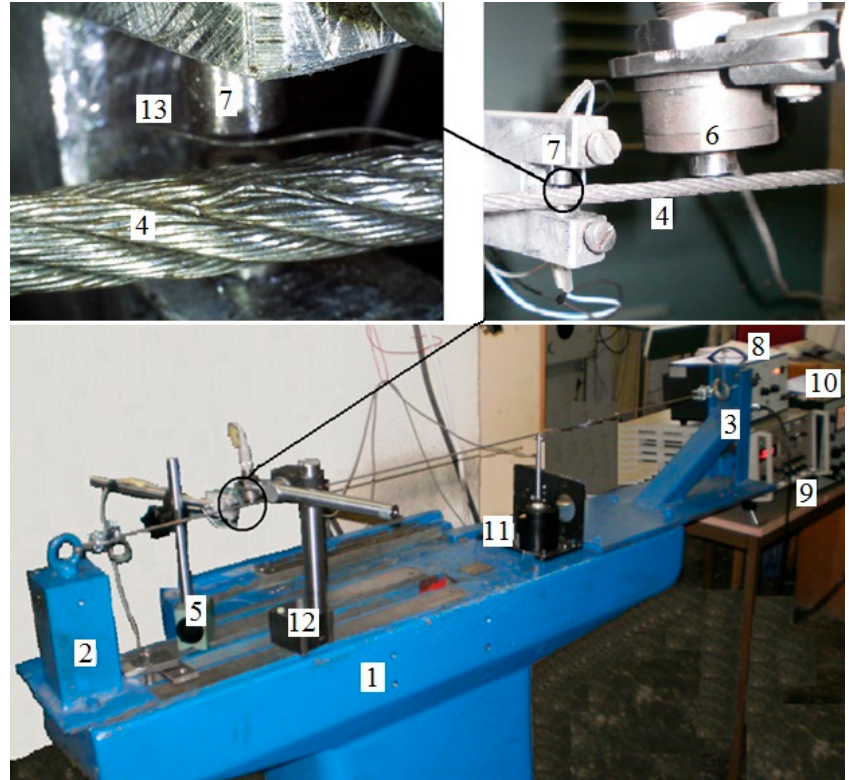
Figure 2. Test rig vibration measuring diagram: 1, frame; 2, rope support; 3, rope support; 4, test rope; 5, holder of transducer Tr4; 6, linear transducer “Hottiger Tr102”; 7, linear transducer “Hottiger Tr4”; 8, power amplifier 2706; 9, amplifier “Hottiger KWS 503 D”; 10, signal generator 1027; 11, electrodynamic mini vibrator 4810; 12, holder of transducer Tr102; and 13, broken wire.